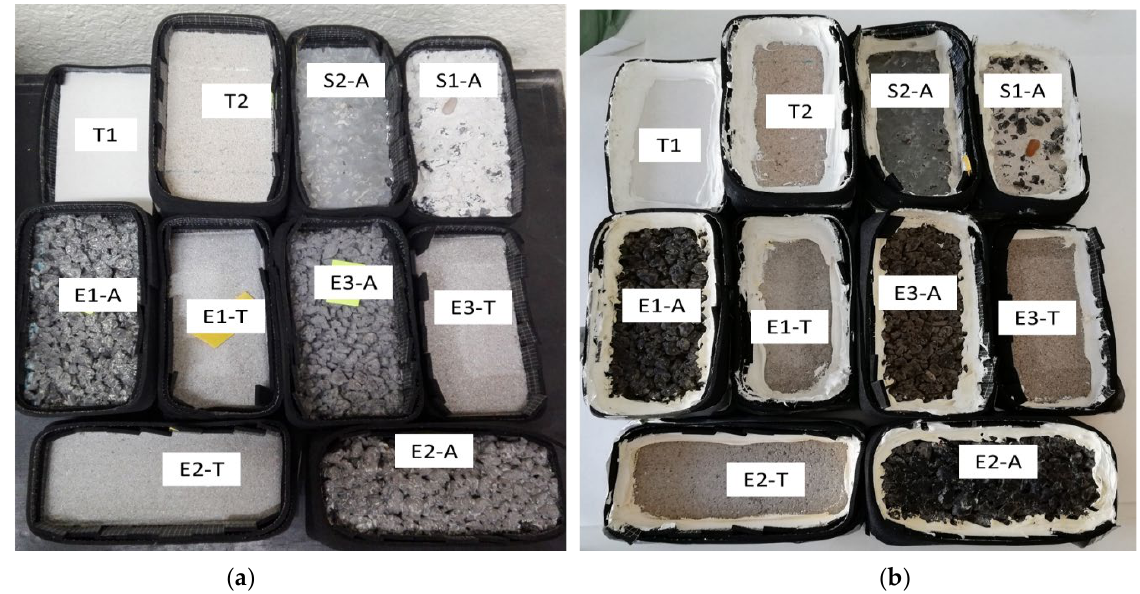
Figure 6. Photocatalytic specimens ( a ) before and ( b ) after the freeze-thaw test. The optical micrographs in Figure 7 show that in addition to the change in colour, the slurry-based samples, showed some cracks, whilst the white photocatalytic layer was missing altogether in the emulsion-coated materials. Most of the samples bore an obvious resemblance to the reference materials.